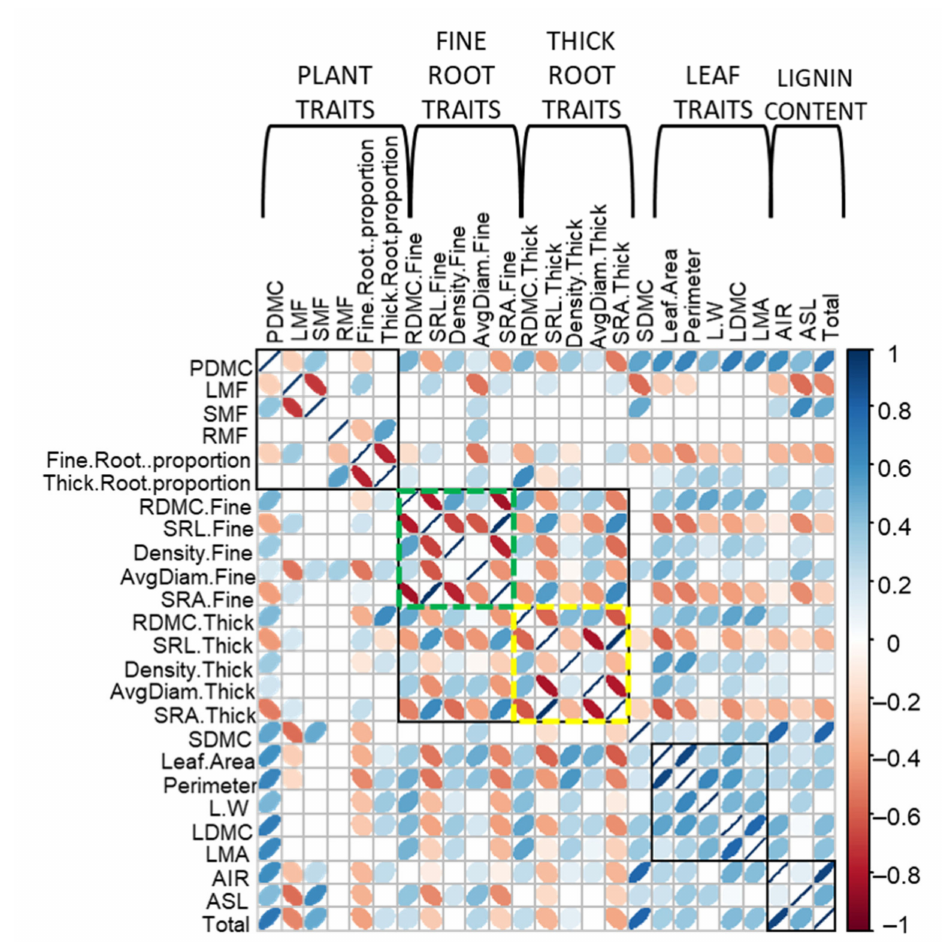
Figure 5. Bivariate correlation matrix between functional traits of the six olive varieties (Empeltre, Frantoio, Picual, Hojiblanca, Nevado fino y Lech í n de Sevilla) here under study. Left and right ellipse inclination indicate significant negative and positive correlation, respectively. Blue and red colors indicate significant positive and negative correlations, respectively ( p < 0.05). A high correlation coefficient is indicated with thin ellipses. Black squares group all functional traits of a specific plant organ (i.e., root, leaf and the entire plant) or trait (i.e., lignin content). Green and yellow squares group the functional traits for fine and thick roots,